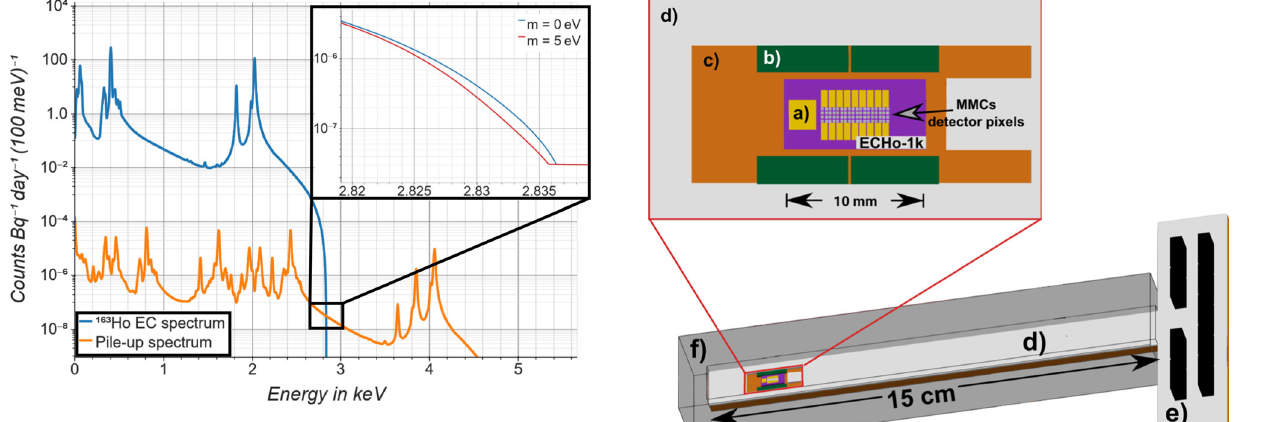
Fig. 1 Expected 163 Ho EC spectrum (blue solid curve) following [3] and related unresolved pile-up spectrum for a pile-up fraction of 10 − 6 (orange solid curve) and considering events with equal and opposite polarity. A Q-value of 2.833keV and an energy resolution of FWHM = 10eV are used to calculate the spectra. Inset: The effect of massive neutrinos on the summed spectrum is shown